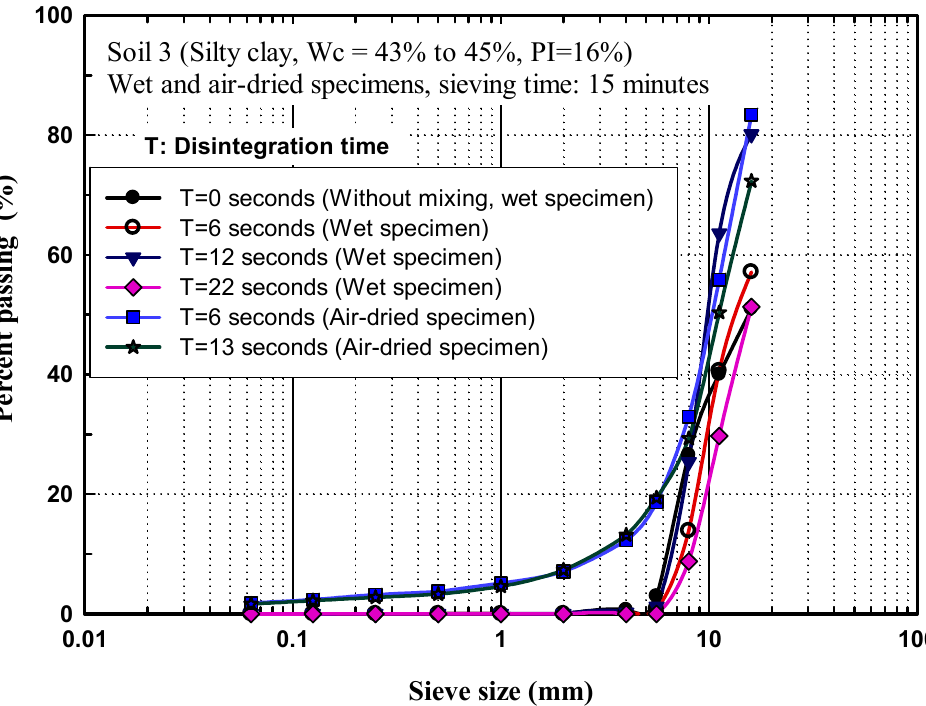
Figure 11. Percentage passing through versus sieve size for wet specimens prepared at di ff erent disintegration times for Soil 3.